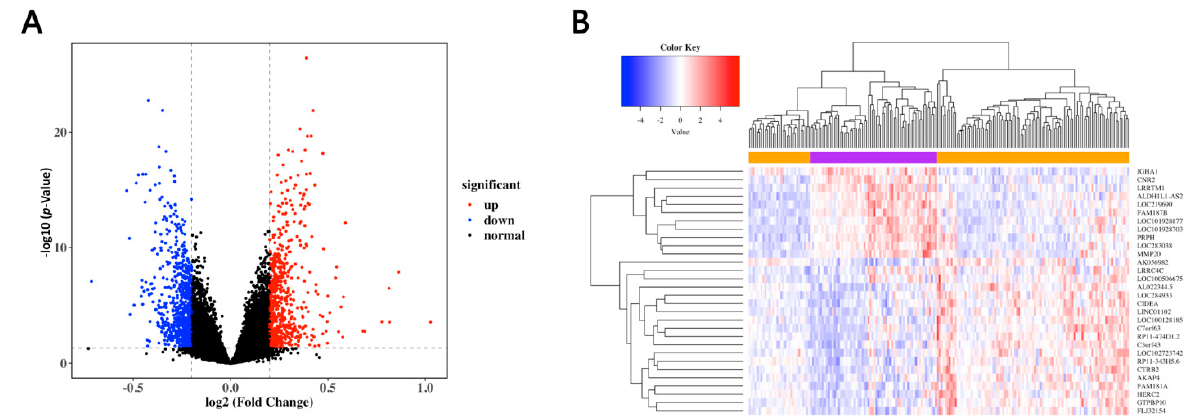
Figure 2. Identification of the DEGs in GES98793. ( A ) Volcano plots of differentially expressed genes (DEGs) in the MDD patients and healthy controls. The red and blue dots represent the up-regulated and down-regulated genes, respectively, while the black dots refer to the non-DEGs. ( B ) Heat map of the top 50 DEGs in the MDD patients and healthy controls.